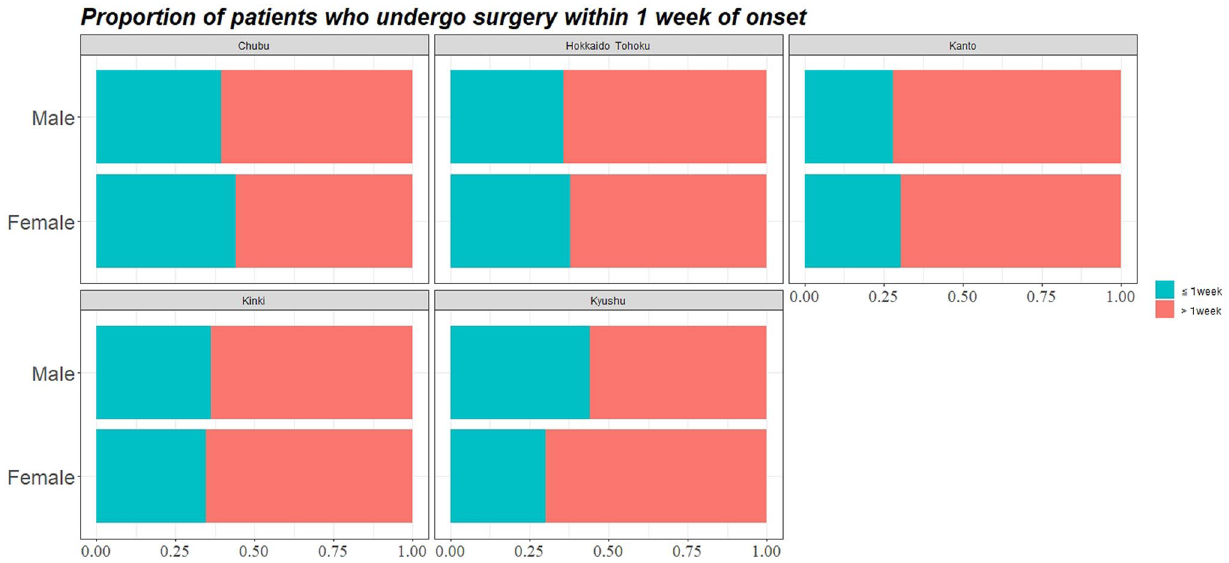
Figure 1. Comparison of the proportion of patients who undergo surgery within 1 week of onset between genders by